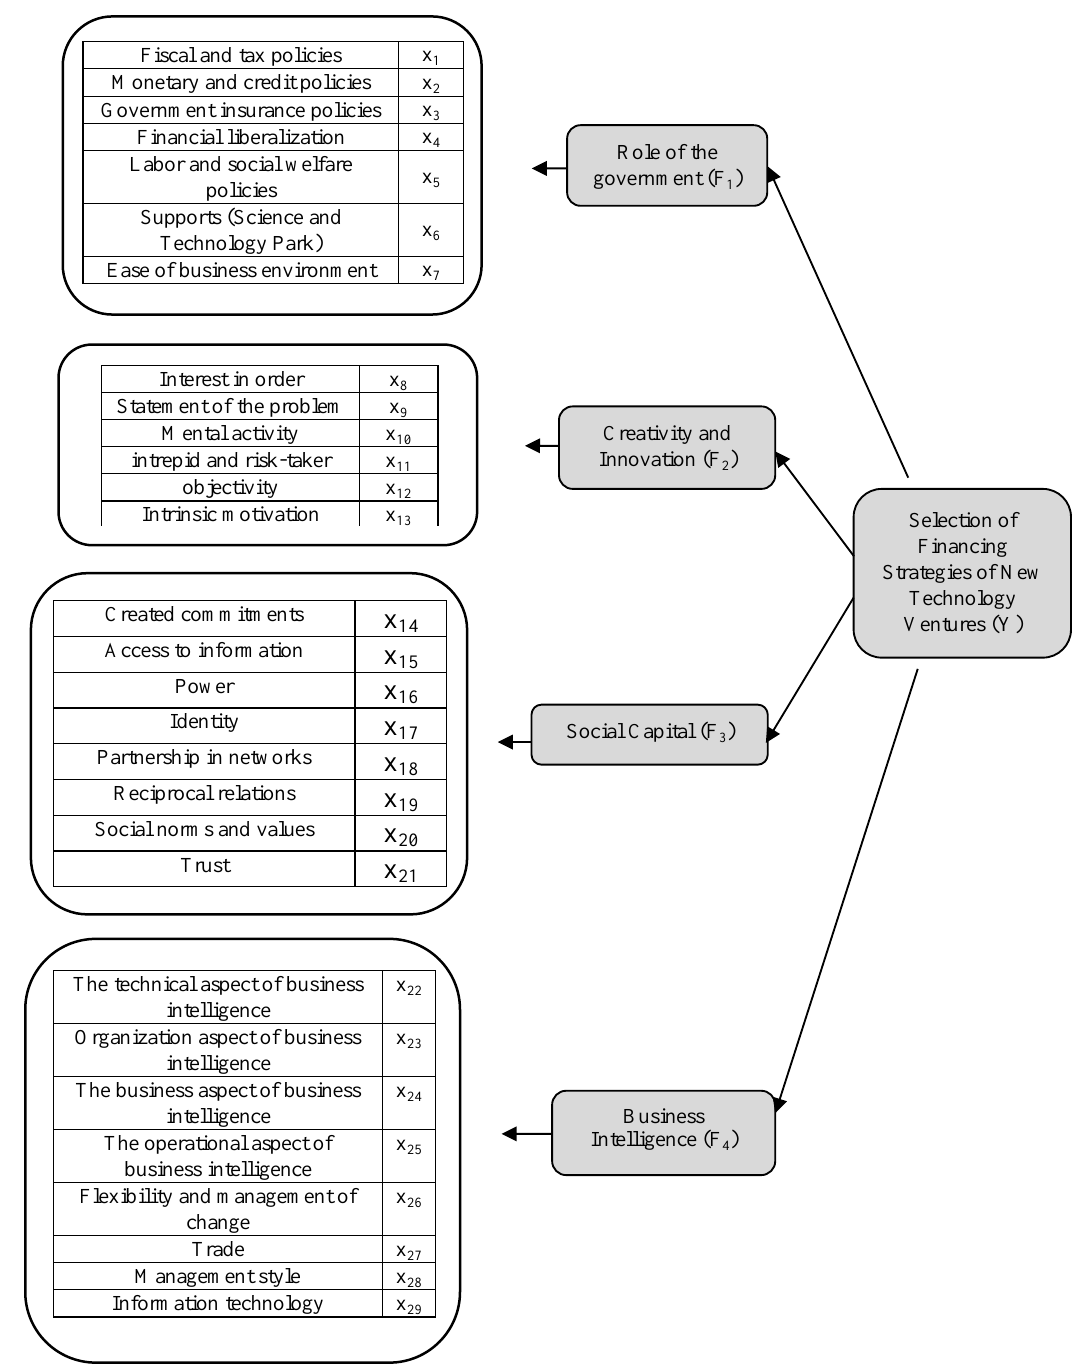
Fig. 2: Primary Conceptual Pattern of Research Source: (Findings of Researcher,